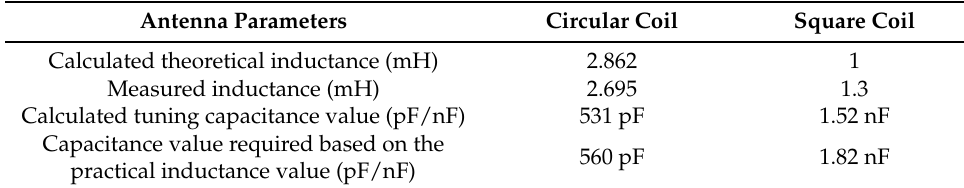
Table 6. The theoretical and practical antenna parameters.